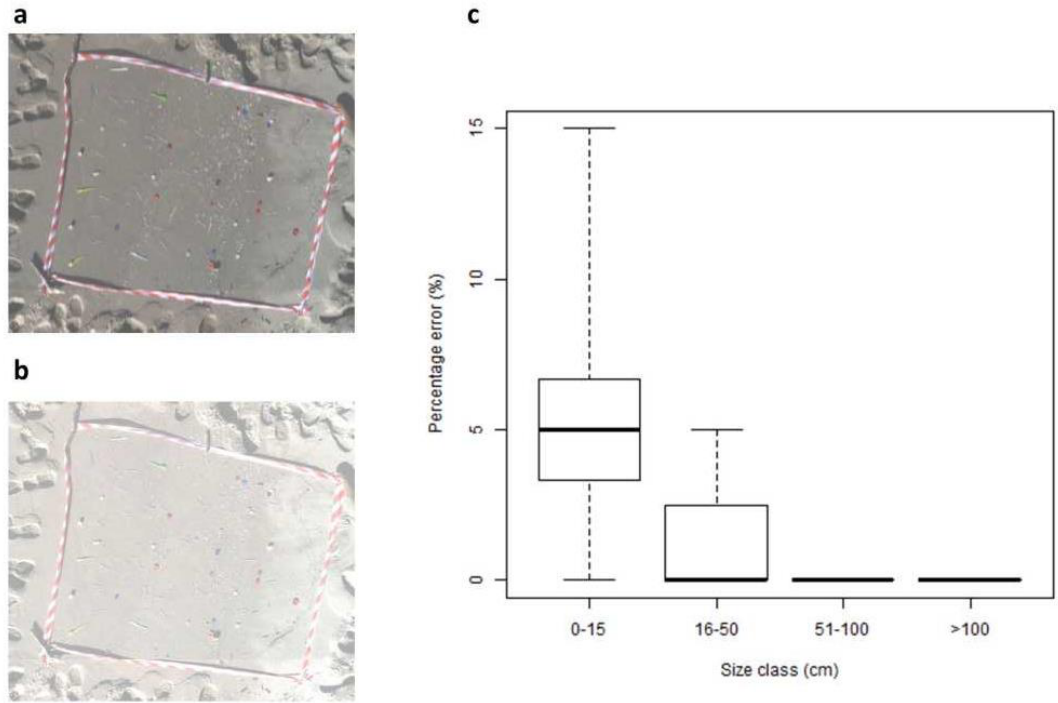
Figure 7. Error evaluation on items counting estimation in ( a ) good weather condition; ( b ) a case of possible bad weather/not optimal visual condition; and ( c ) boxplot of percentage error in items counting (PE N ) per size (linear dimension, following OSPAR guidelines prescriptions). PE N was calculated with Microsoft Excel and the boxplots were made with the R 3.4.1 software for windows (https://www.r-project.org/). PD N indicates the percentage of detected objects by UAVs; PD N = 100 − PE N .